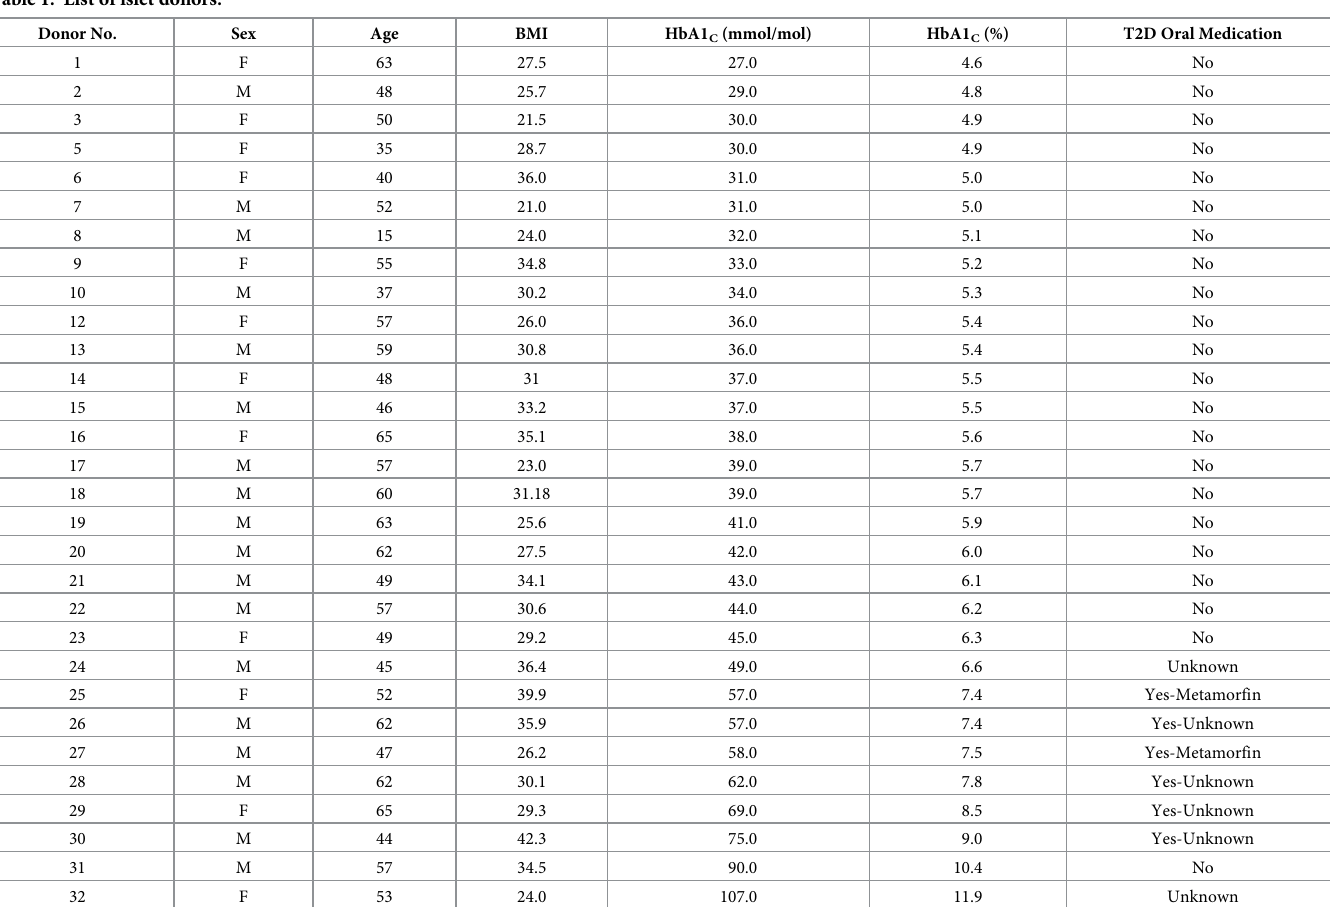
Table 1. List of islet